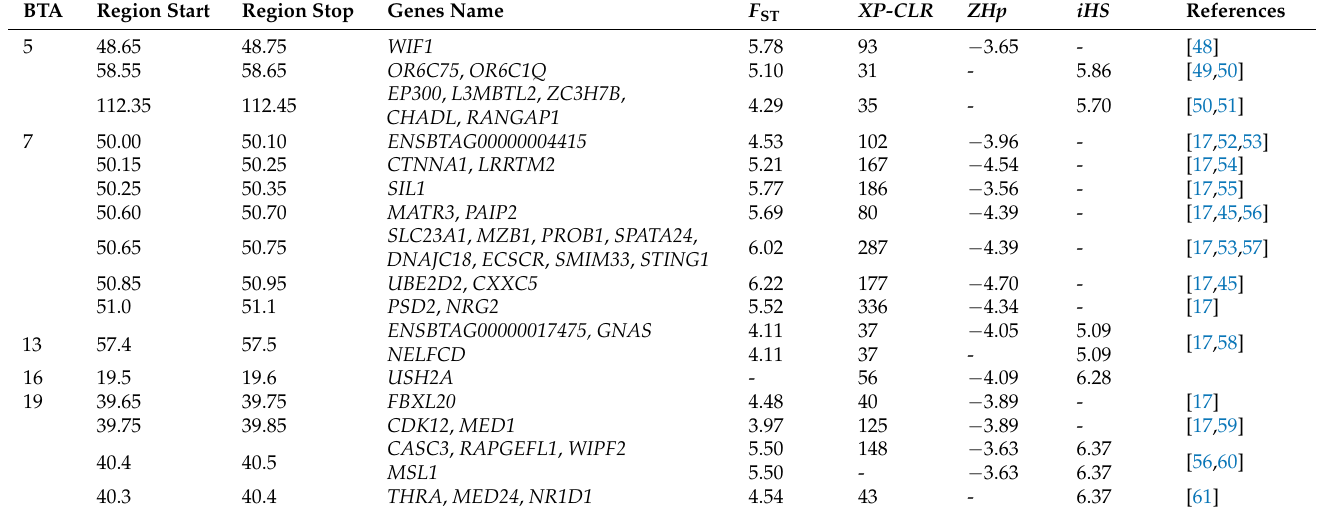
Table 4. Candidate gene regions (Mb) and protein-coding genes in Ethiopian cattle commonly detected by three of the four genome scan